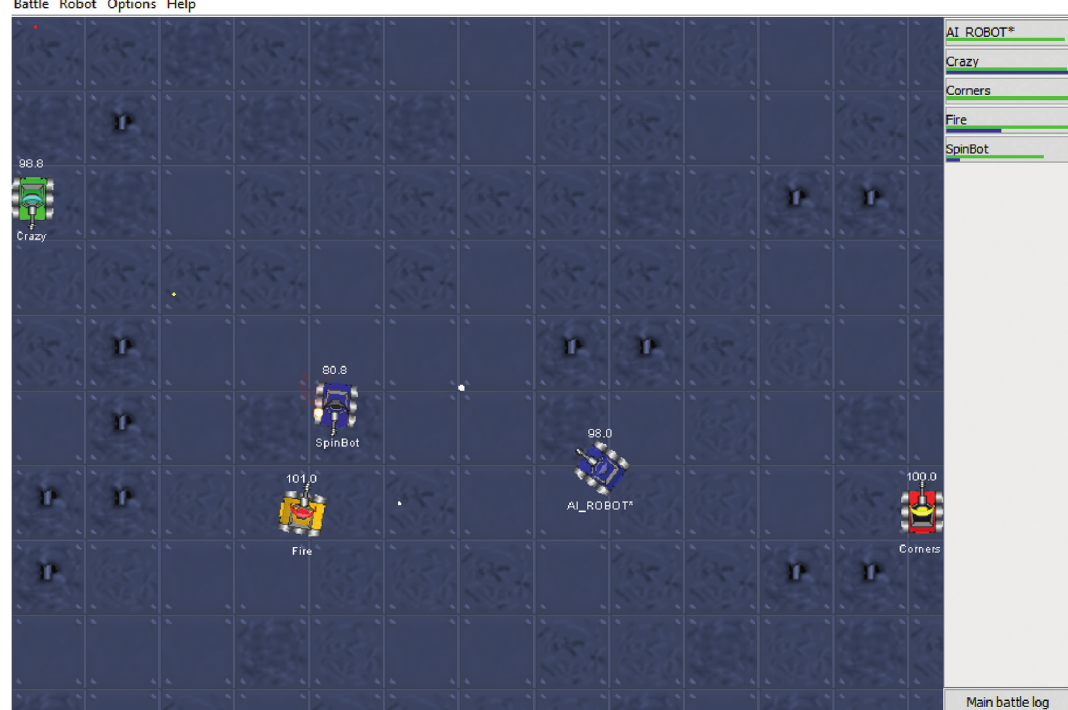
Figure 1: An example screenshot obtained from the RoboCode battle